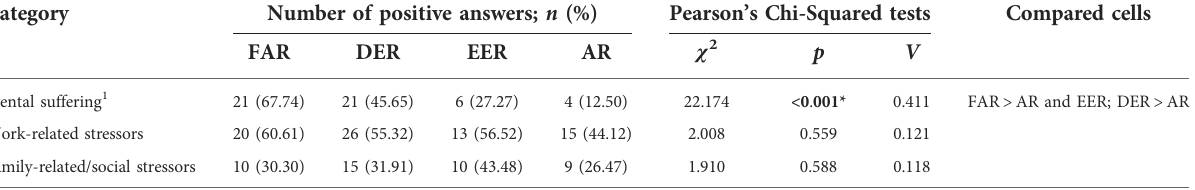
TABLE 4 Numbers of positive answers of deductive categories per AEM-subgroup and results of Pearson ’ s Chi-Squared tests to compare the subgroups within these categories . Category Number of positive answers; n (%)